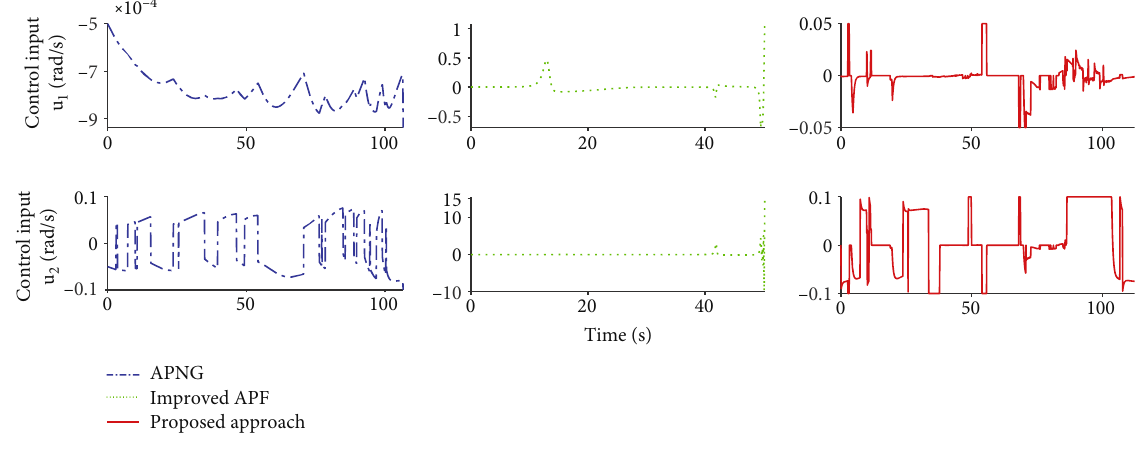
Figure 30: Changes of control inputs in case 6. Table 4: The generation rules of the target maneuver input in Monte Carlo experiment.